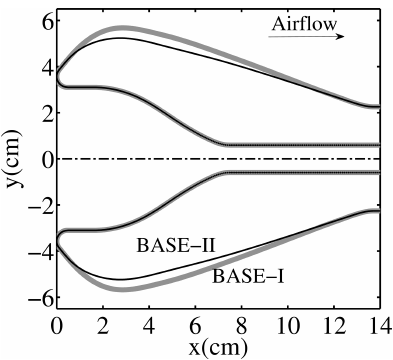
Figure 6. Profiles of the blunt body housing for BASE-I and BASE- II